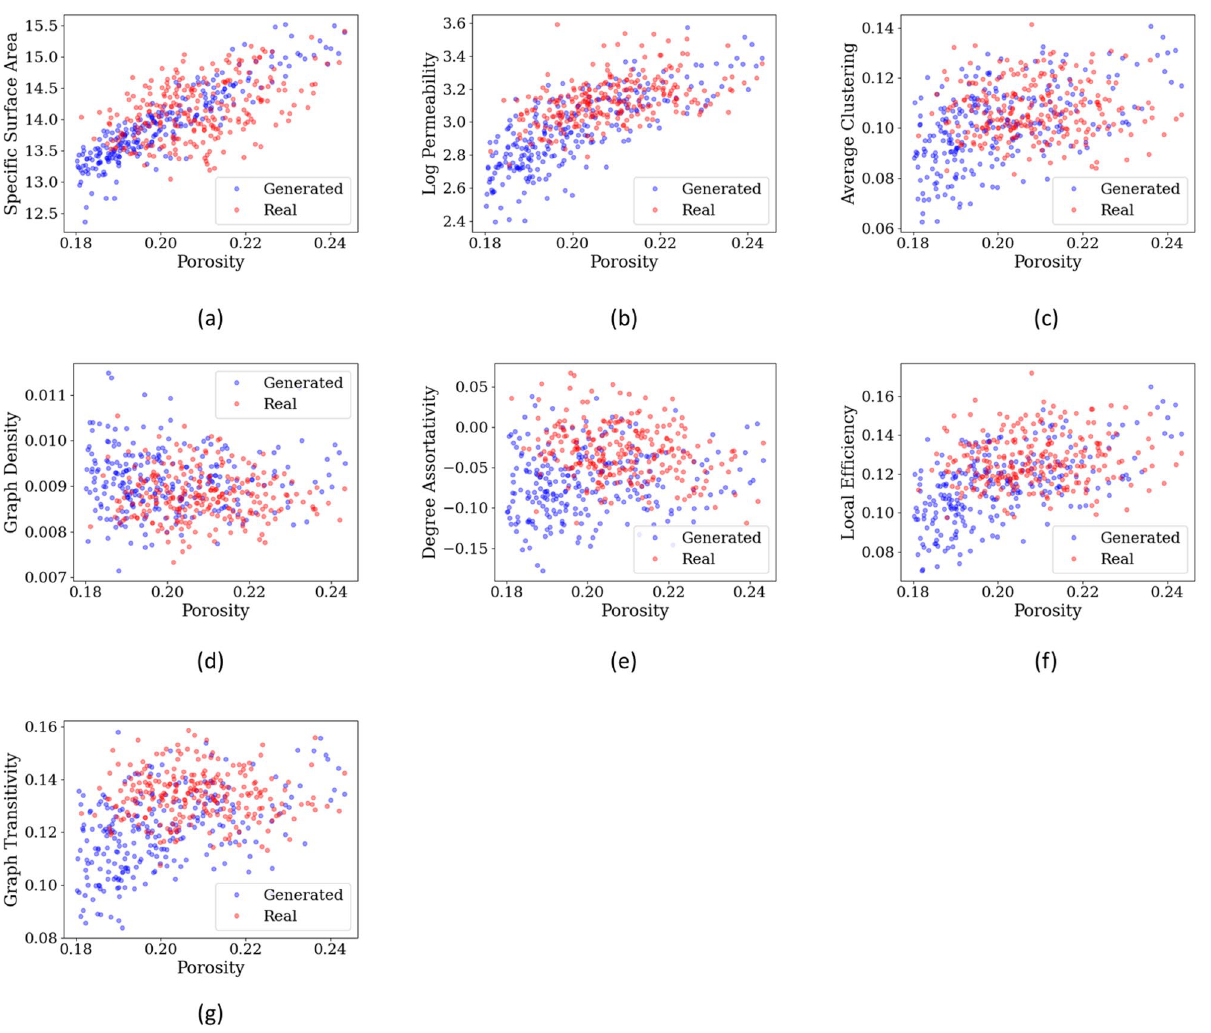
Figure 6. Quantitative evaluation of 3D synthetic microstructures. Pore space measurements, topology measurements, and permeability are plotted w.r.t porosity. ( a ) specific surface area, ( b ) log permeability (md), ( c ) average clustering, ( d ) graph density, ( e ) degree assortativity coefficient, ( f ) local efficiency, and ( g ) graph transitivity. As seen in the plots, there is an agreement between physical properties of